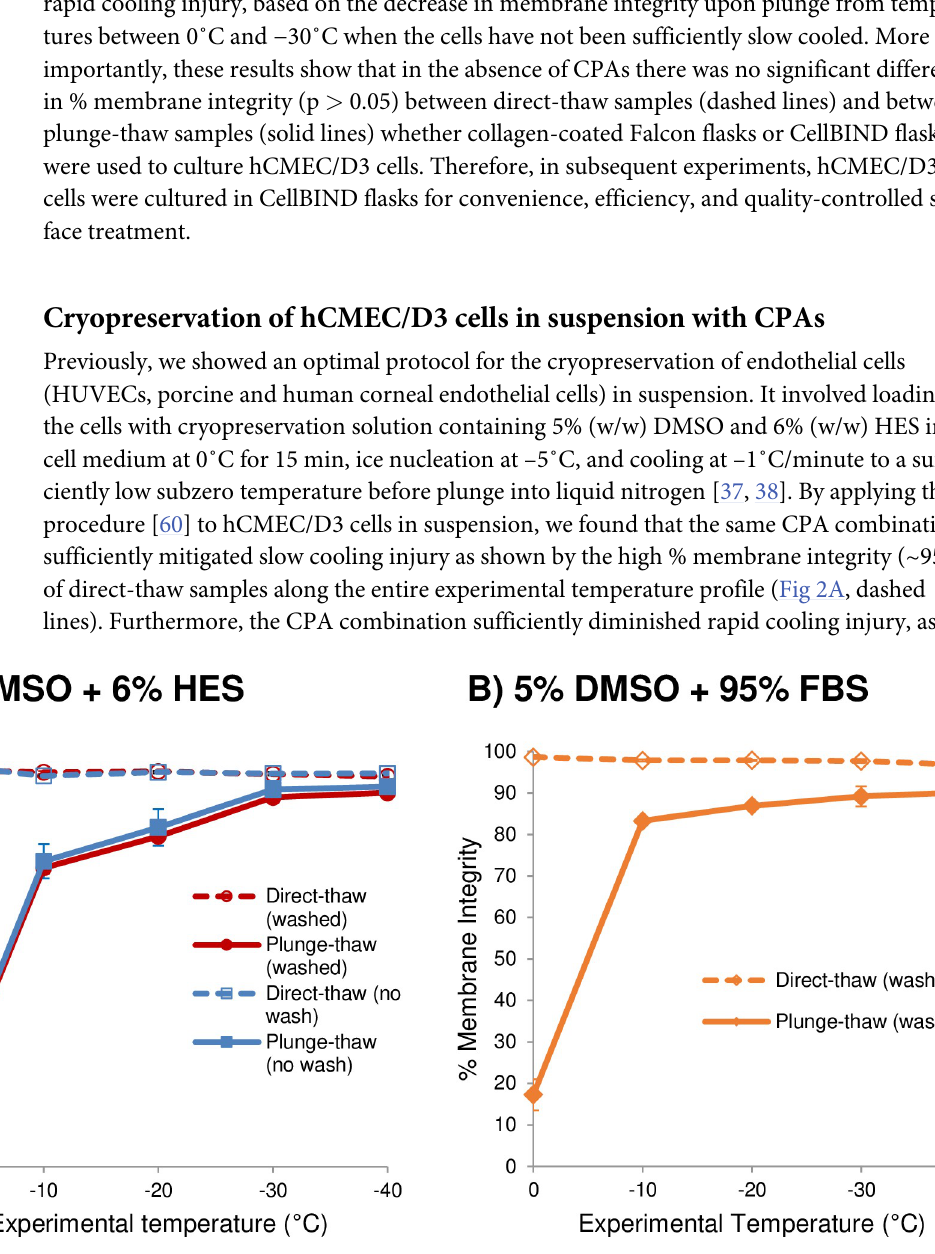
Fig 2. Graded freezing of hCMEC/D3 cells in suspension in the presence of CPAs. (A) 5% DMSO and 6% HES in medium or (B) 5% DMSO in 95% FBS. Cells were cooled at 1˚C/min to sub-zero temperatures. At each temperature, one sample was thawed directly (direct-thaw, dashed lines), and another sample was immediately plunged into liquid nitrogen, and then thawed (plunge-thaw, solid lines). In (A) the cells were either washed or not washed after thaw. Washing was carried out by centrifugation at 140 g for 5 min, and removal of the supernatant before re-suspending the pellet in 400 μ L PBS. Membrane integrities are shown as mean ± SEM from three independent experiments. Membrane integrity was not significantly different between cells that were washed or not washed post-thaw (p > 0.05). In (A), there was a significant difference between plunging from –10˚C and –30˚C or –40˚C (p < 0.015 for no wash samples and p = 0.0004 for washed samples). In (B), there was no significant difference between plunging from –10˚C and –30˚C (p = 0.08), but there was a significant difference between plunging from –10˚C and –40˚C (p =